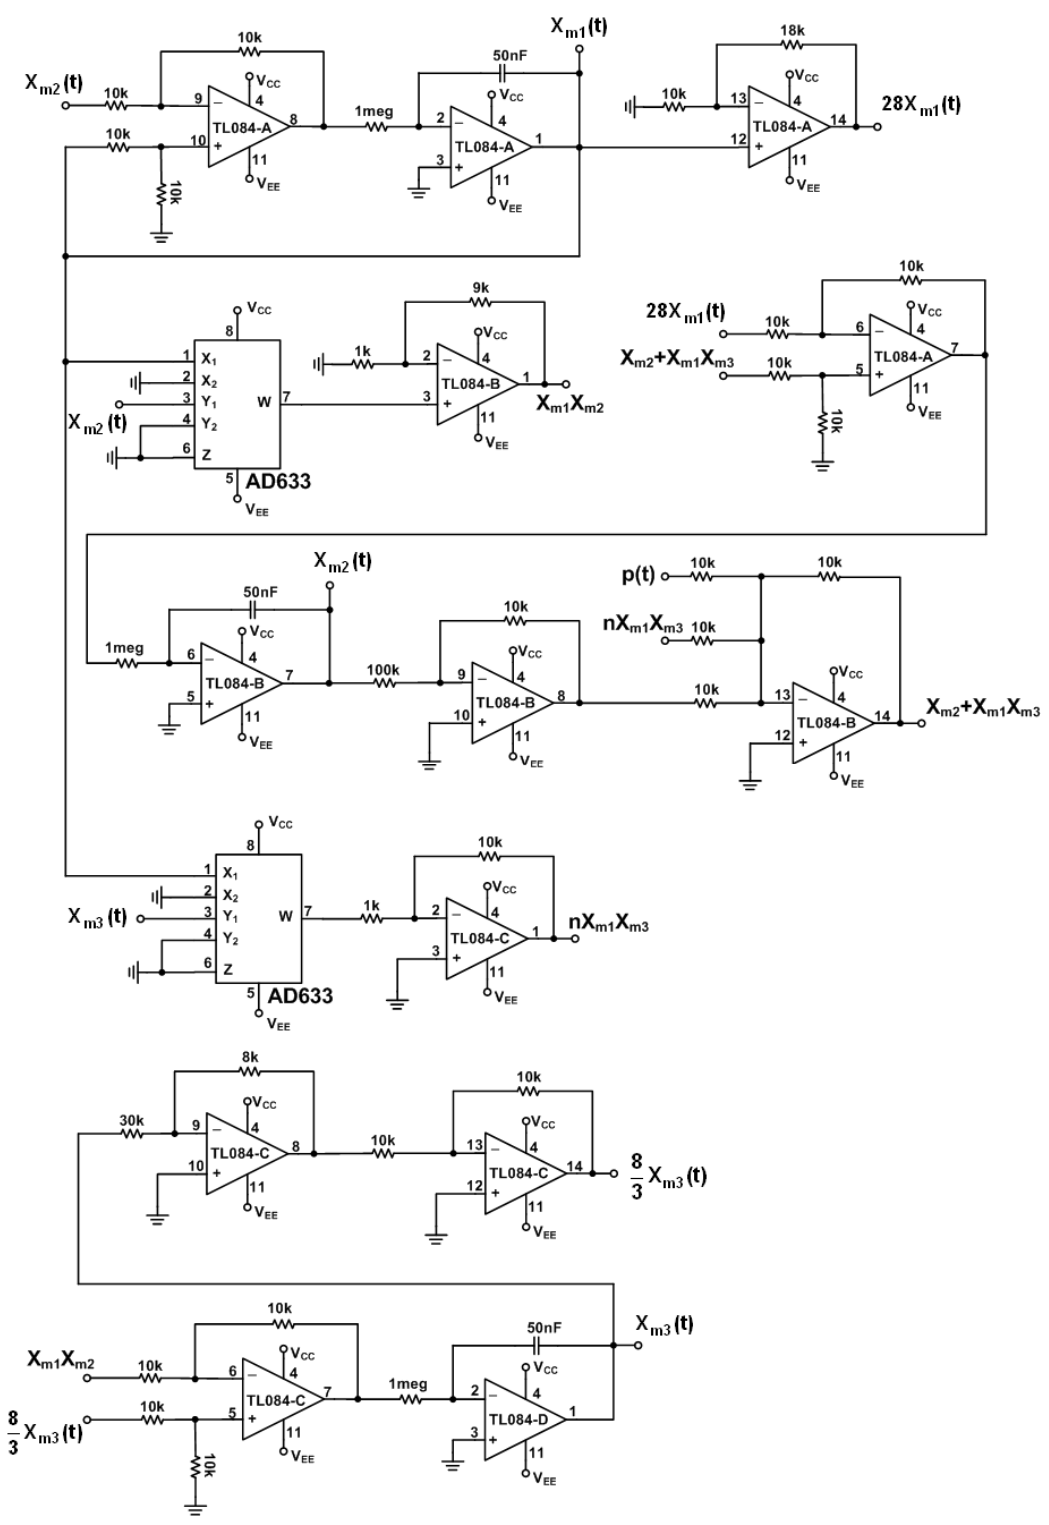
Figure 2. Electronic implementation of the master Lorenz